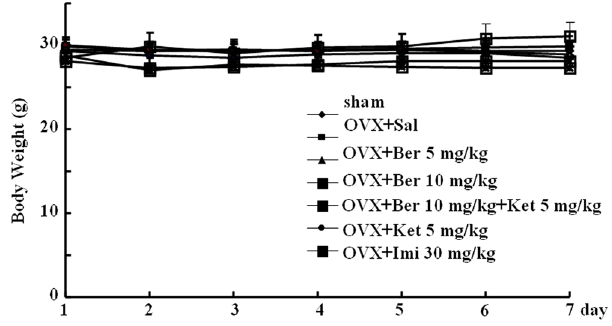
Figure 1. Body weight in subjects from all groups over the 7-day course of pharmacological treatment. sham-treated mice (sham) and ovariectomized (OVX) mice treated with saline (OVX + Sal), 5 mg/kg berberine (OVX + Ber 5 mg/kg), 10 mg/kg berberine (OVX + Ber 10 mg/kg), 10 mg/kg berberine + ketanserin (OVX + 10 mg/kg Ber + Ket, ketanserin only (OVX + Ket 5 mg/kg), or imipramine (OVX + Imi 30 mg/kg).